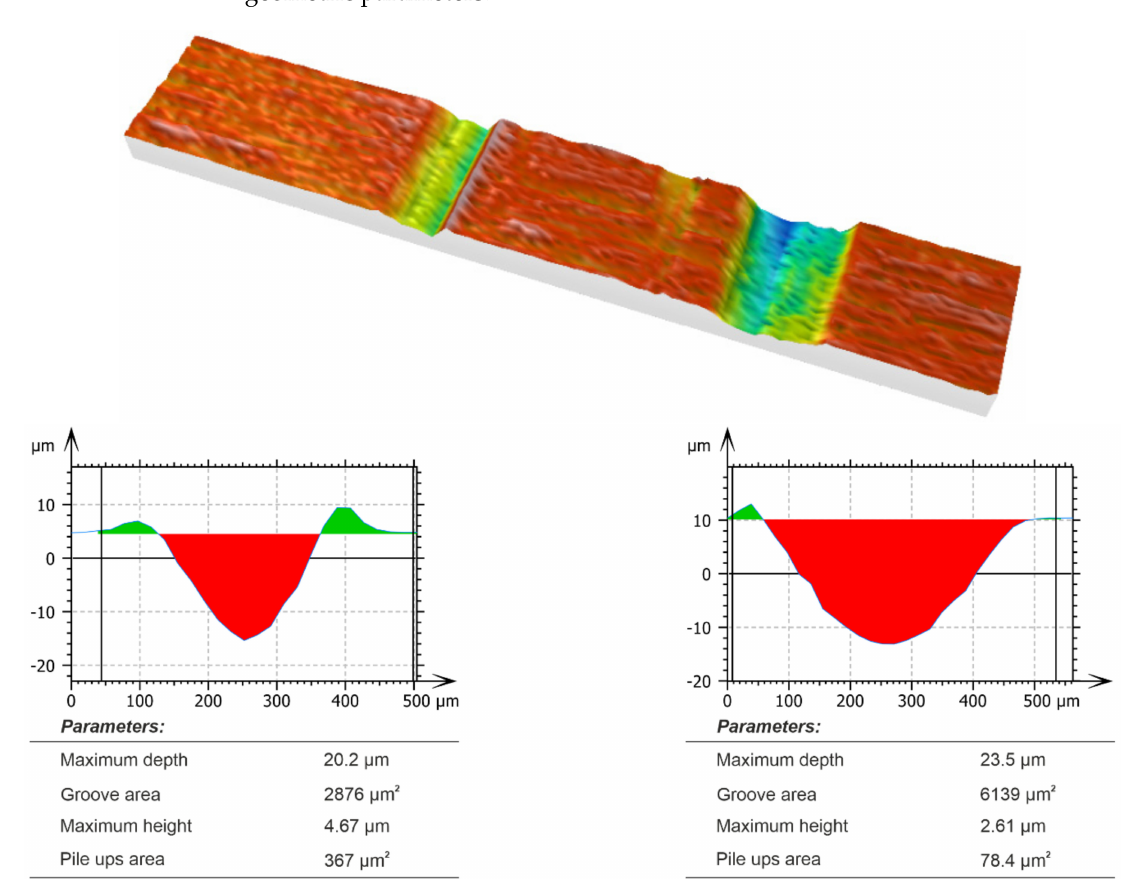
Figure 9. Cross-sections of the scratches—experimental